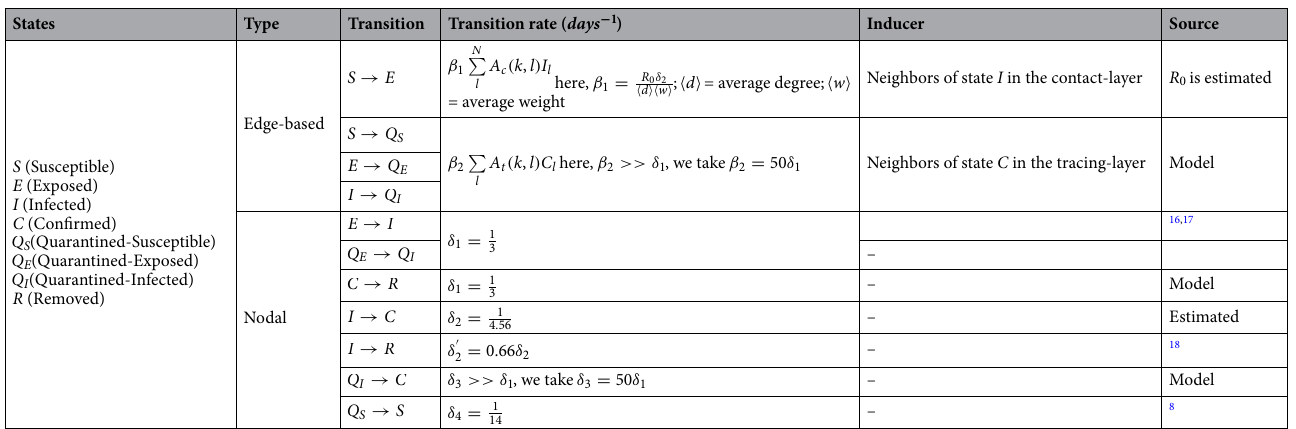
Table 5. Description of the SEICQ1 epidemic model.